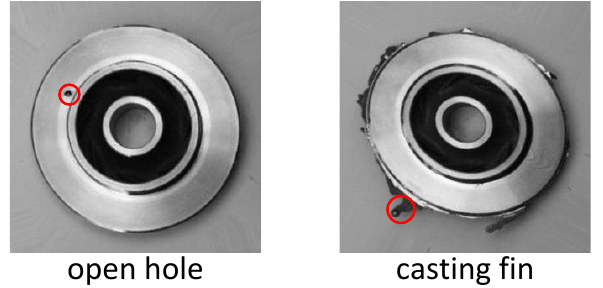
Figure 7. The examples of the open hole defect and the casting fin defect. The red circles are manually